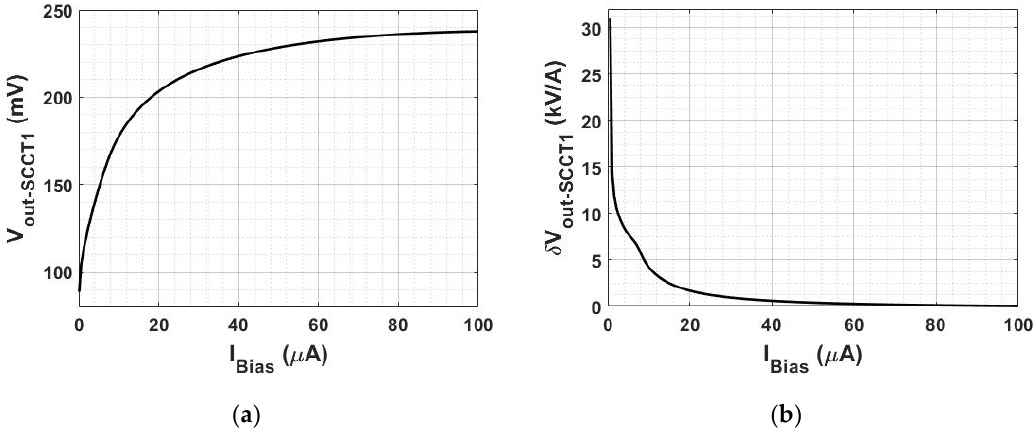
Figure 7. ( a ) V out of SCCT1 and its ( b ) derivative as function of I Bias .